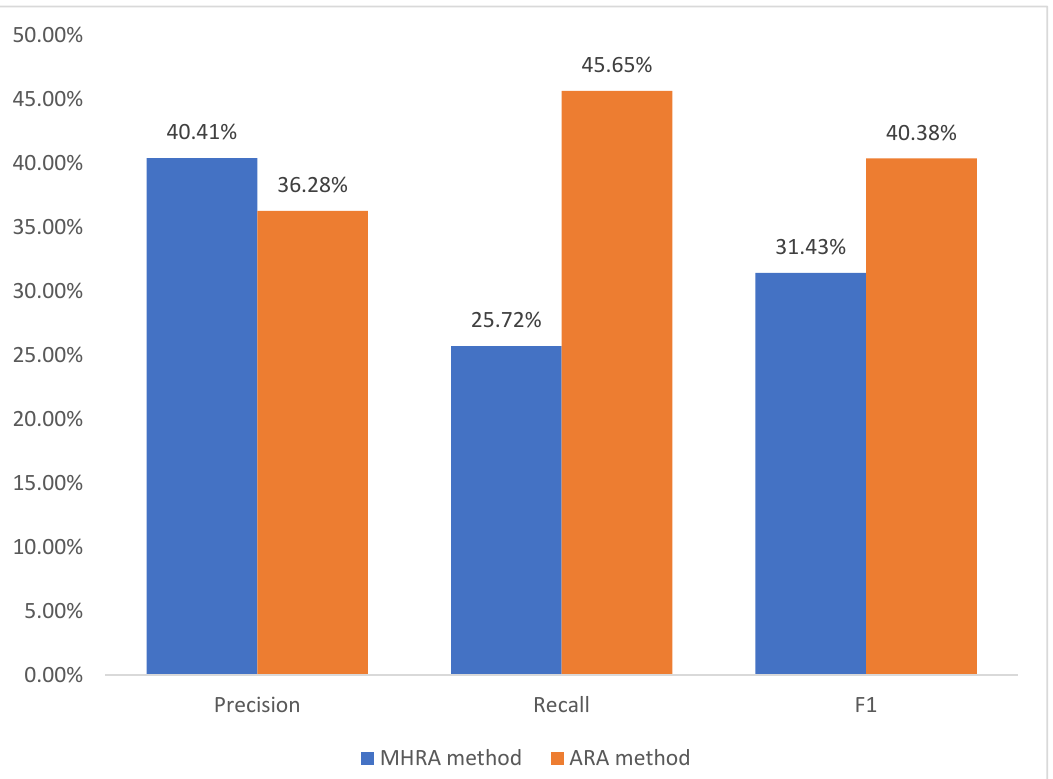
Figure 1. Comparison of the performance of the MHRA method and the ARA method.